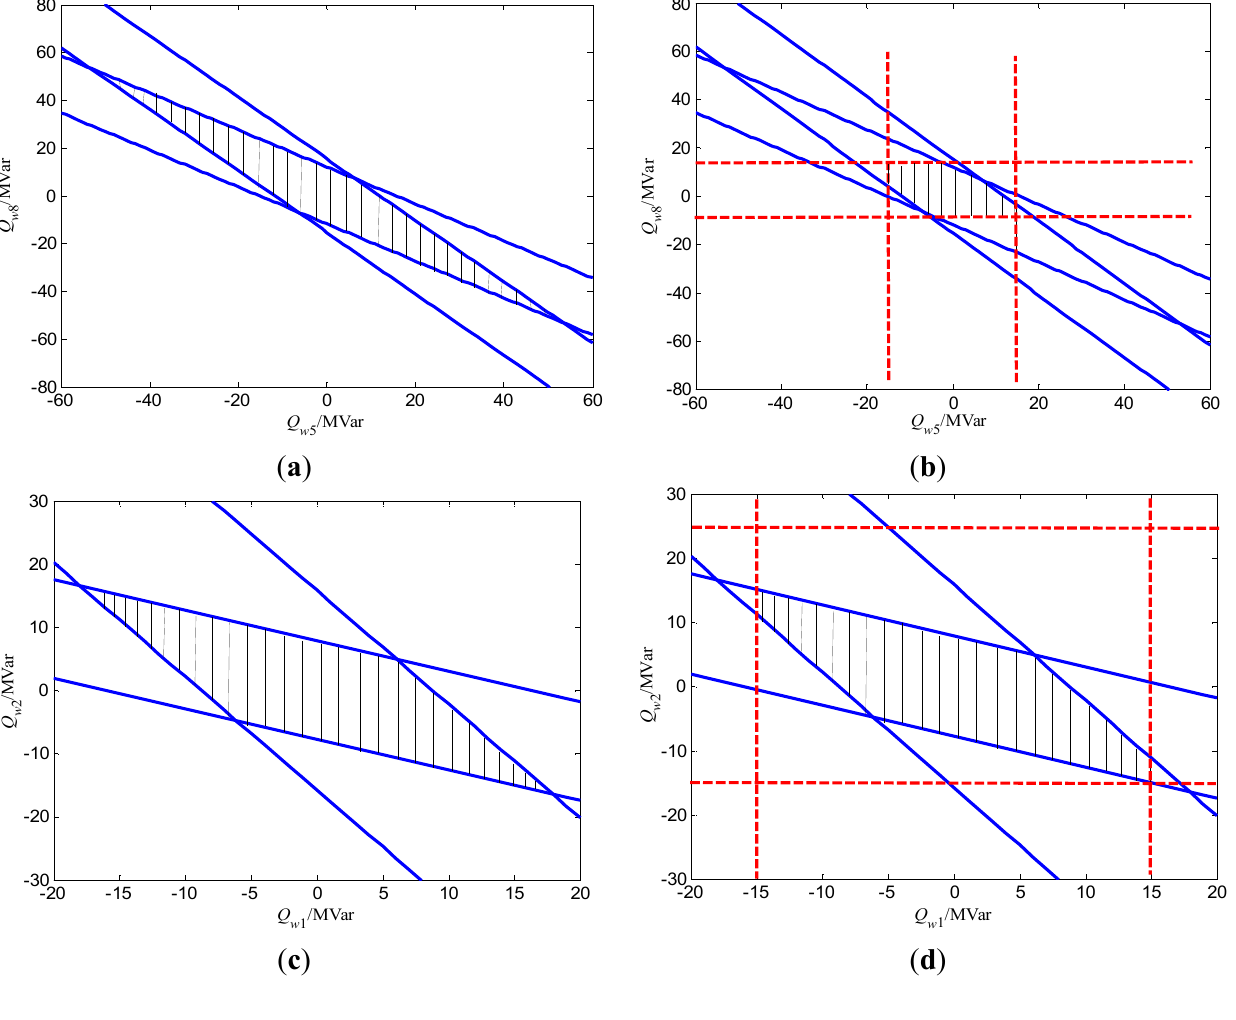
Figure 12. Projection of voltage security region on the two-dimensional plane: , Q ) plane; ( b ) Projection of final ( a ) Projection of initial voltage security region on ( Q w 1 w 2 , Q ) plane; ( c ) Projection of initial voltage security region voltage security region on ( Q w 1 w 2 , Q ) plane; ( d ) Projection of final voltage security region on ( Q , Q ) on ( Q w 5 w 8 w 5 w 8